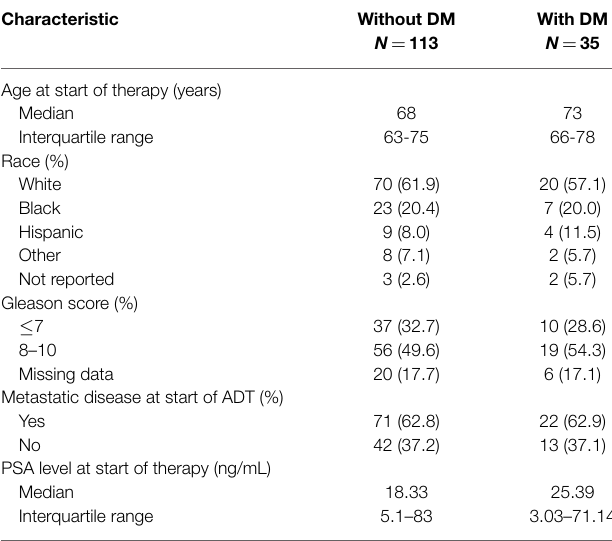
TABLE 1 | Characteristics of eligible patients